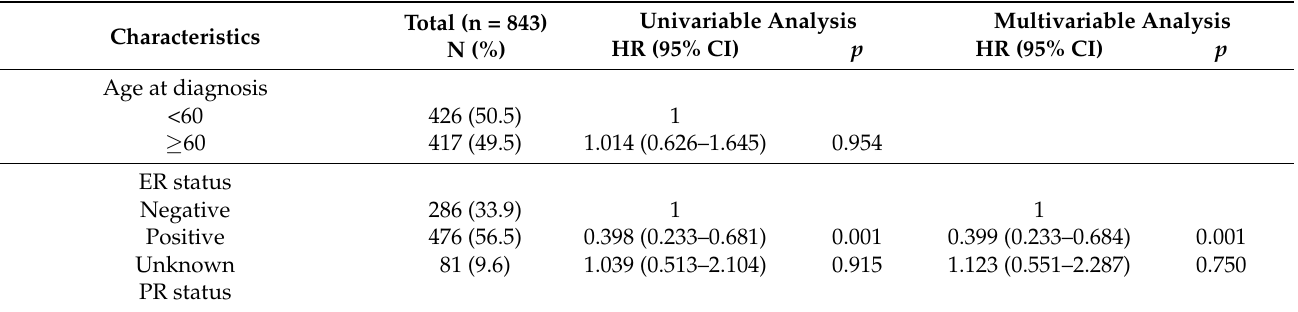
Table 3. Univariate and multivariable analyses of the prognostic factors.